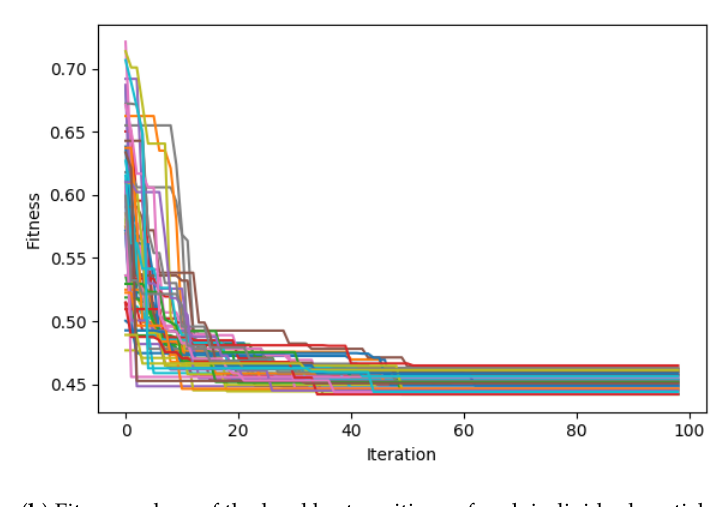
Figure 16. Fitness values for the current and local best positions of each individual particle throughout the optimisation process using no weight inheritance method.